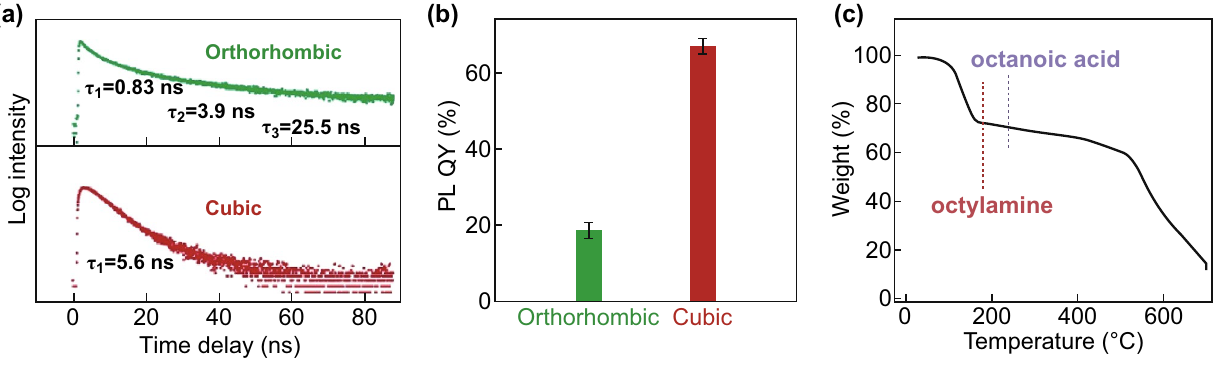
Fig. 3 a Lifetime measurement at 520 nm and b PL QY of CsPbBr 3 NCs, showing a phase dependence. A 410-nm pulsed laser was used as excitation source, and the PL bands from 450 to 600 nm were monitored as emission. c TGA of nanosheets shows ample surface coverage of